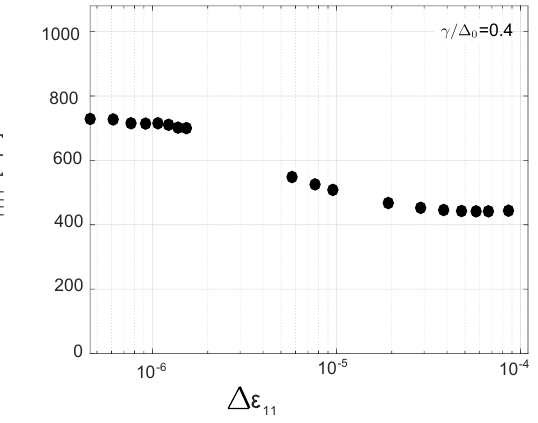
Figure 3. Sti ff ness component A 1111 versus applied perturbation at stressed state corresponding with γ/ ∆ 0 = 0 . 4.